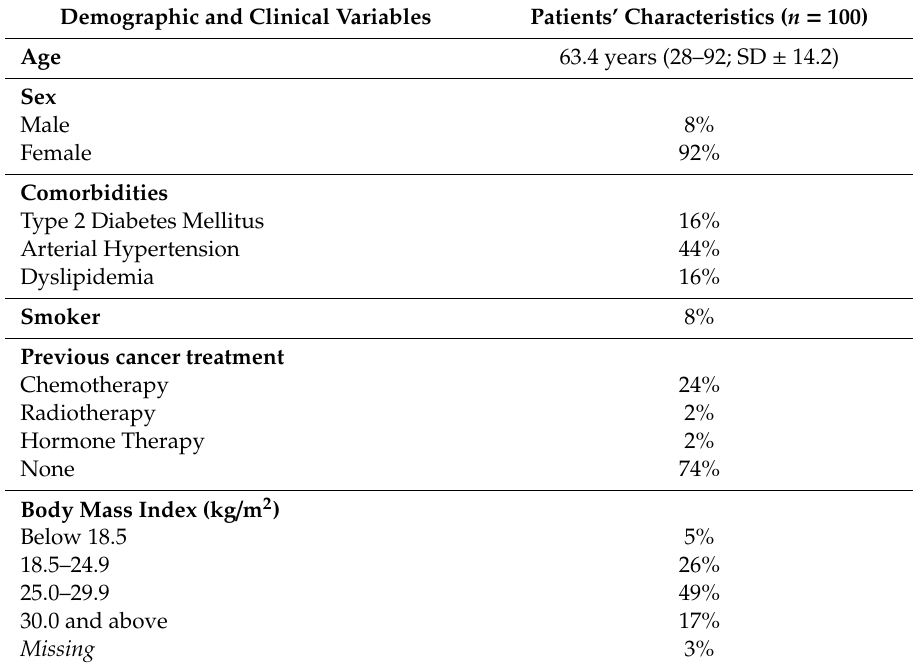
Table 2. Demographic and clinical characteristics of the study participants ( n = 100)—Phase 2.